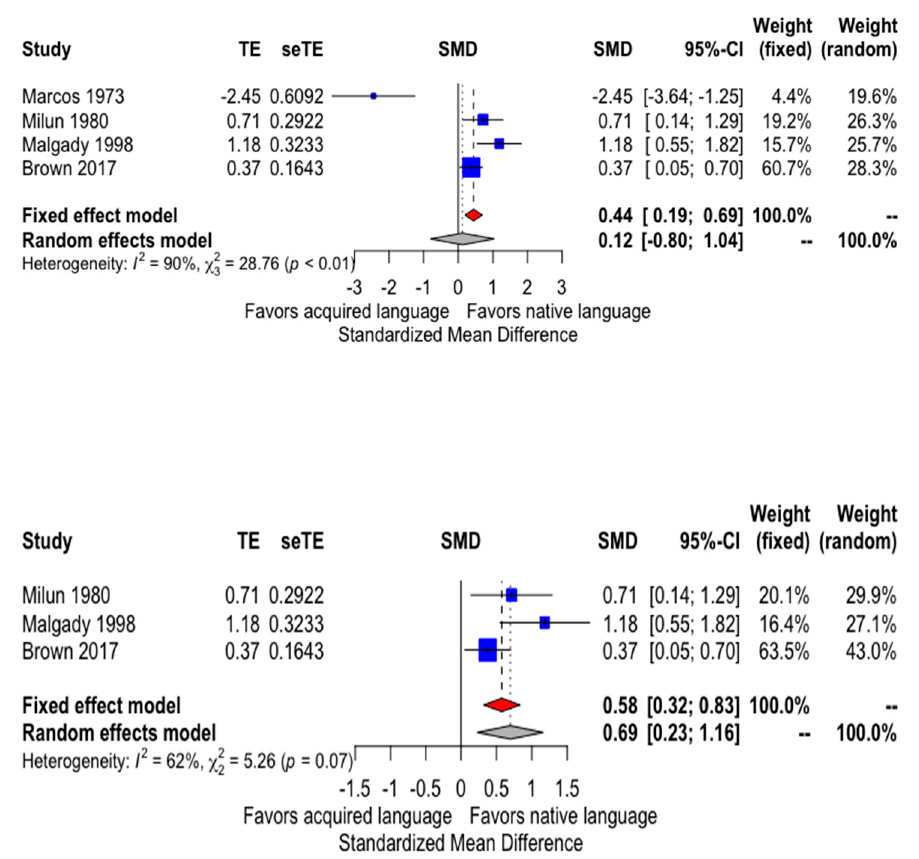
Figure 2. Symptomatic severity scores in bilingual psychotic patients interviewed in their mother or later acquired language. ( upper panel ) Results with the complete set of studies; ( lower panel ) results without the study by Marcos et al. [16]. SMD > 0 indicates more severity in the mother language. Overall, the quality of evidence for the meta-analysis is very low (when including all studies) or low (when excluding Marcos et al. [16]) because of risk of bias (most studies do not present e ff ects model (SMD = 0.69; 95% CI = 0.23, 1.16; p value = 0.0036). Heterogeneity is now moderate (Q-test = 5.26, p value = 0.072) and based on three studies that show the same direction of e ff